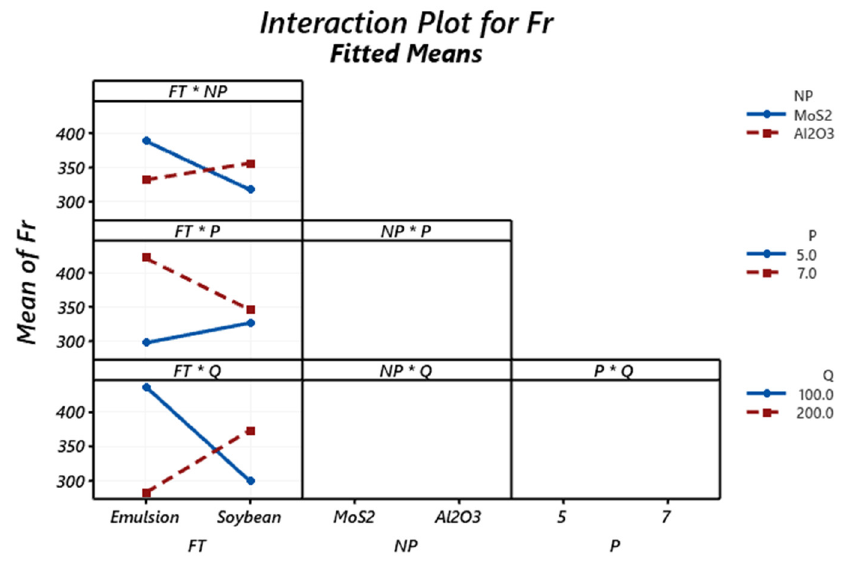
Figure 7. Interaction plot of input machining factors on the resultant cutting force F r.